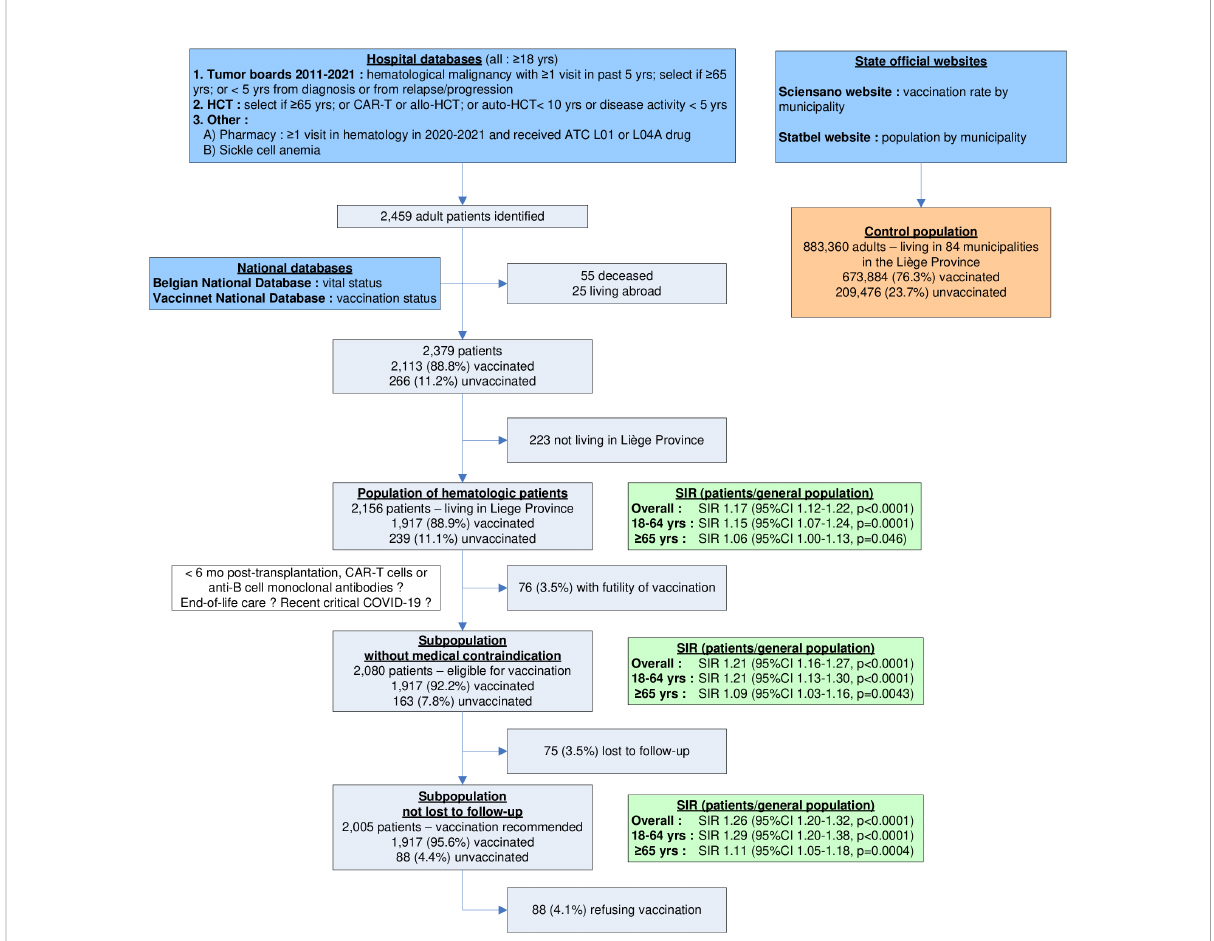
FIGURE 1 Consort diagram showing inclusion criteria for the population of adult hematologic patients (n=2,379). After removing patients not living in the Province of Liège, the overall patient population included 2156 patients. The sub-population of patients without medical contraindication (n=2080) and the subpopulation of patients not lost to follow-up (n=2005) were also analyzed. They were all compared to the adult general population of the Province of Liège (n=883,360). For each patient population, Standardized Incidence Ratios (SIR) with 95% con fi dence intervals were calculated for patients 18-64 yrs, ≥ 65 yrs and overall. SIR greater (smaller) than 1 indicate that vaccination rates in hematologic patients are higher (lower) than in the general population; 95% con fi dence intervals (CI) not encompassing 1 indicate that differences are statistically signi fi